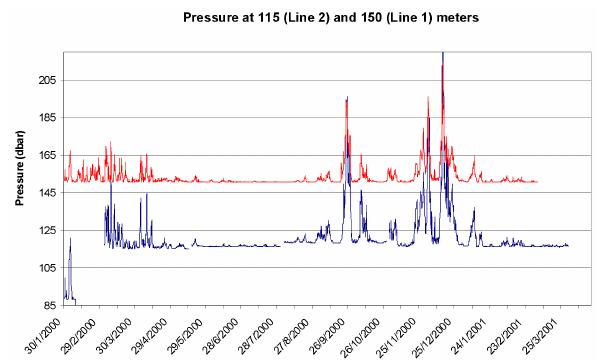
Fig. 7. Time series of current speed at 60m depth. A low pass filter has been used to eliminate variability below